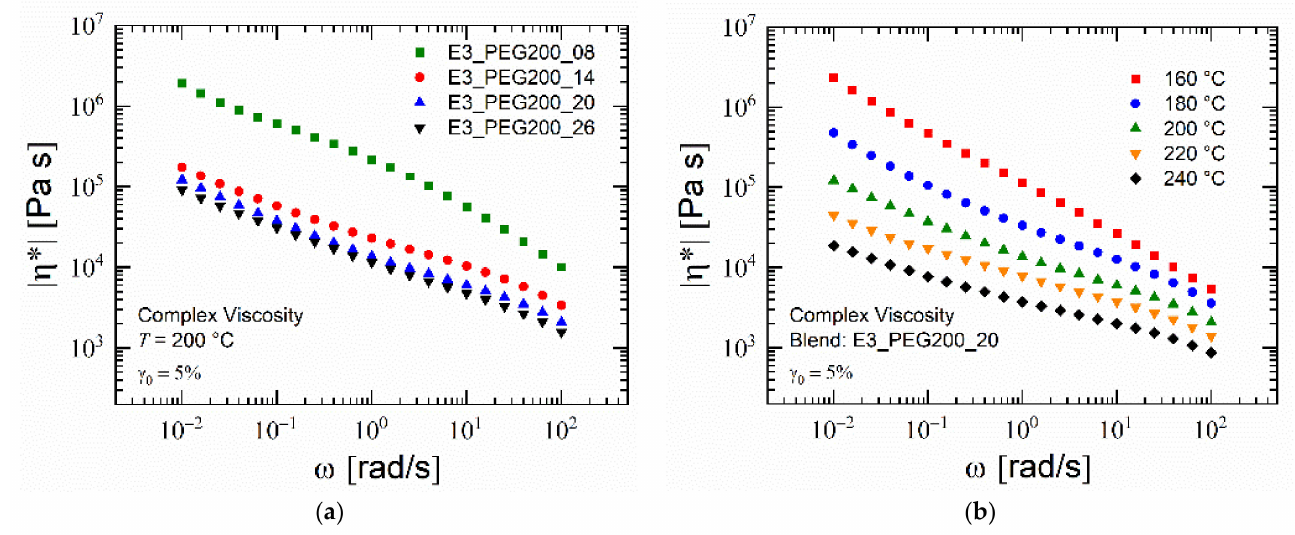
Figure 8. Magnitude of complex viscosity: ( a ) PESU/PEG200 blends at 200 ◦ C; ( b ) blend E3_PEG200_20 at various